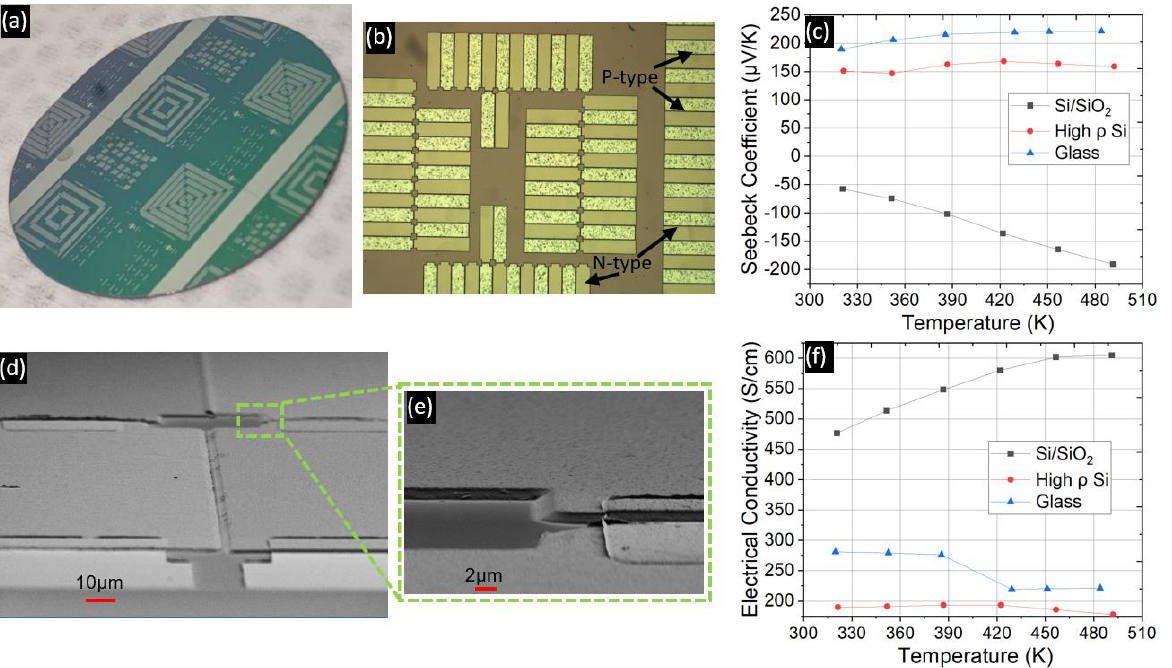
Figure 9. ( a ) Successful lift-off of p-type and n-type thin films on a 2” Si/SiO 2 wafer. N-type thin films were deposited before p-type, requiring a higher post-deposition bake temperature. A 15 nm Cr adhesion layer was deposited in situ before the thermoelectric thin film evaporation. ( b ) Zoomed-in view of the wafer from ( a ). ( c ) Negative Seebeck coefficients were measured on a Si/SiO 2 substrate where a Cr adhesion layer was deposited before evaporation of the pellets. The data with a positive Seebeck coefficient corresponds to samples loaded during the same run but on glass and high resistivity ( ρ) Si substrates. ( f ) Corresponding electrical conductivity data. ( d ) SEM images showing the thermocouples displayed in ( a , b ). Ni contacts deposited over the thermoelectric thin films to form test structures are also visible ( e ) The zoomed-in view shows the slope of the thermoelectric thin films indicating that the rotation of the wafer can distort the boundary of the features and highlighting the importance of a large undercut during the lithography.